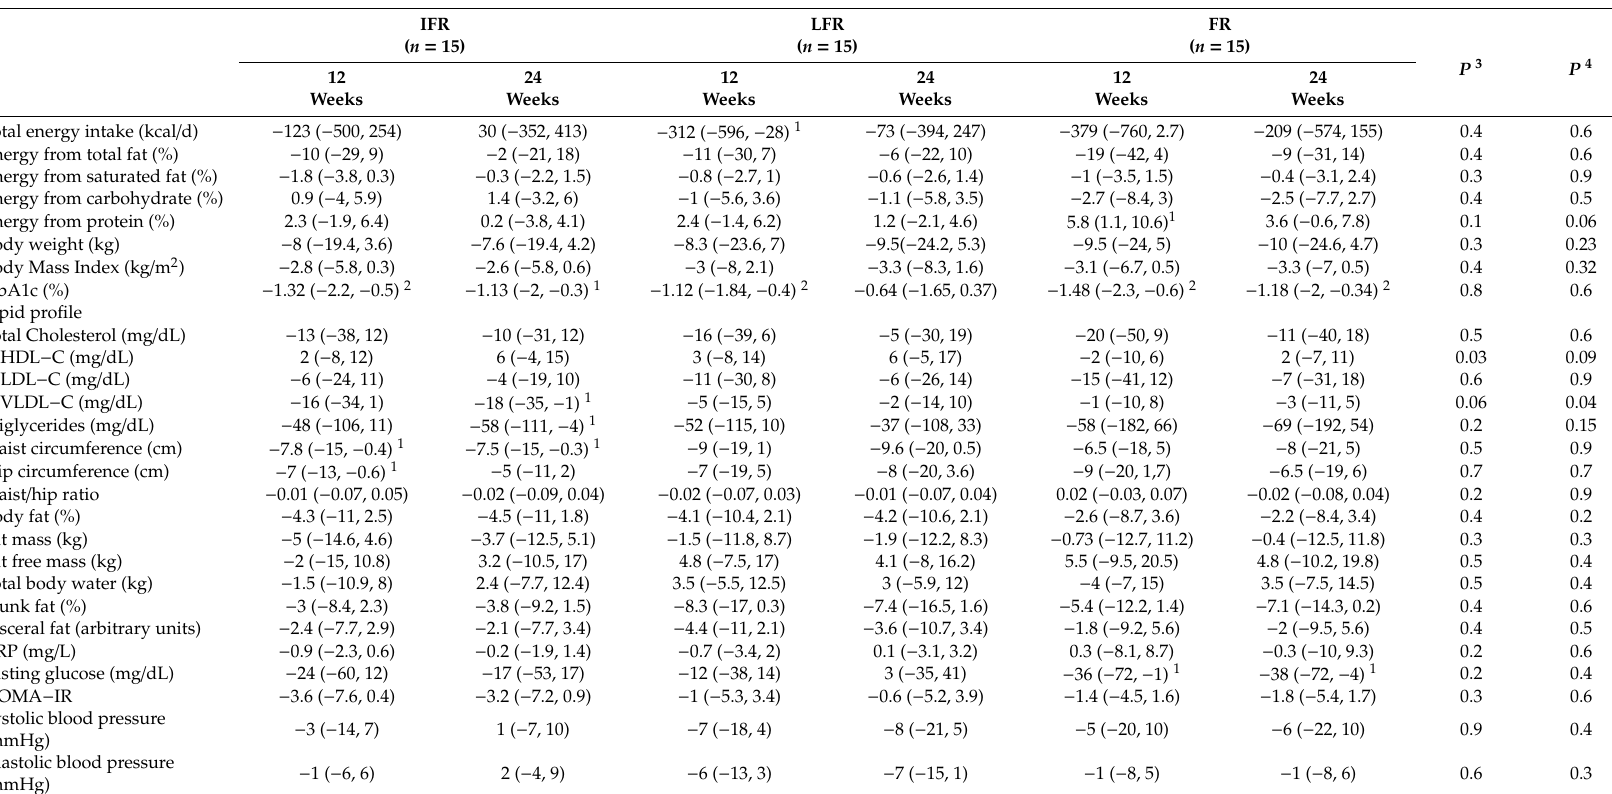
Table 2. Changes from baseline in dietary intake and cardiometabolic parameters at the end of intervention phase (12 weeks) of intensive medical weight management and at the end of maintenance phase (24 weeks) among patients with type 2 diabetes and overweight or obesity stratified by frequency of dairy